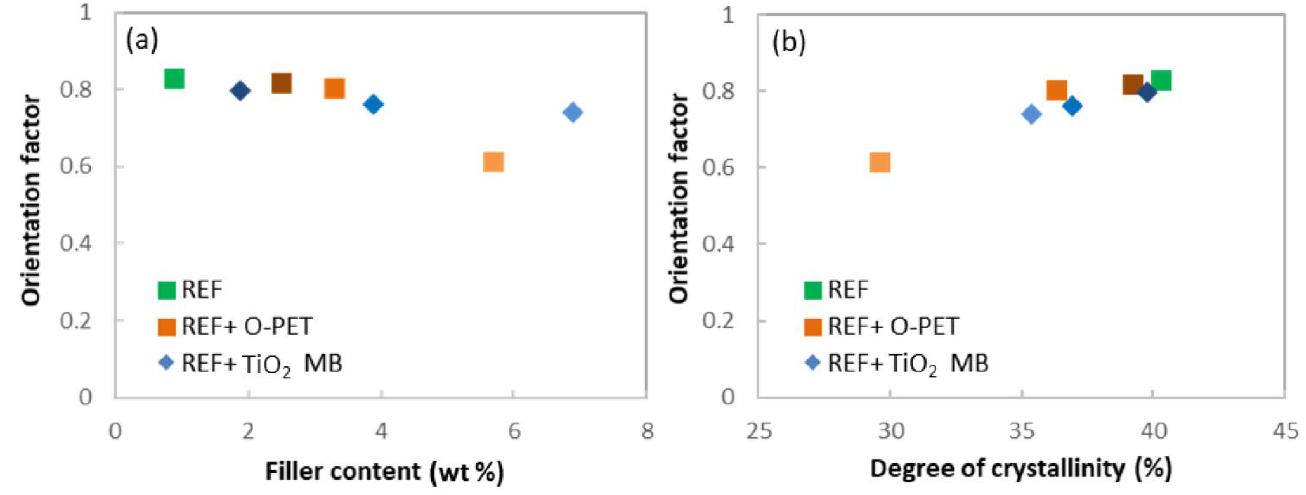
Figure 6. ( a ) Orientation factor (f c ) versus filler content (wt %) and ( b ) Orientation factor versus degree of crystallinity (%); for the two sets of filaments and the reference (green).